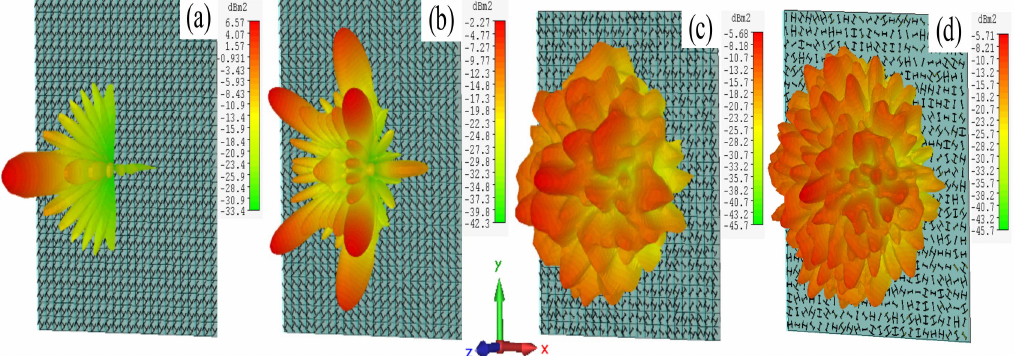
Figure 11. Simulation far-field patterns of the scattering of coding metasurfaces with di ff erent coding sequences ( a ) 1-bit 00 / 00 or 11 / 11 PCM structure; ( b ) 1-bit chessboard structure; ( c ) 3-bit coding metasurface and ( d ) 3-bit coding metasurface of random rotation angle at 20